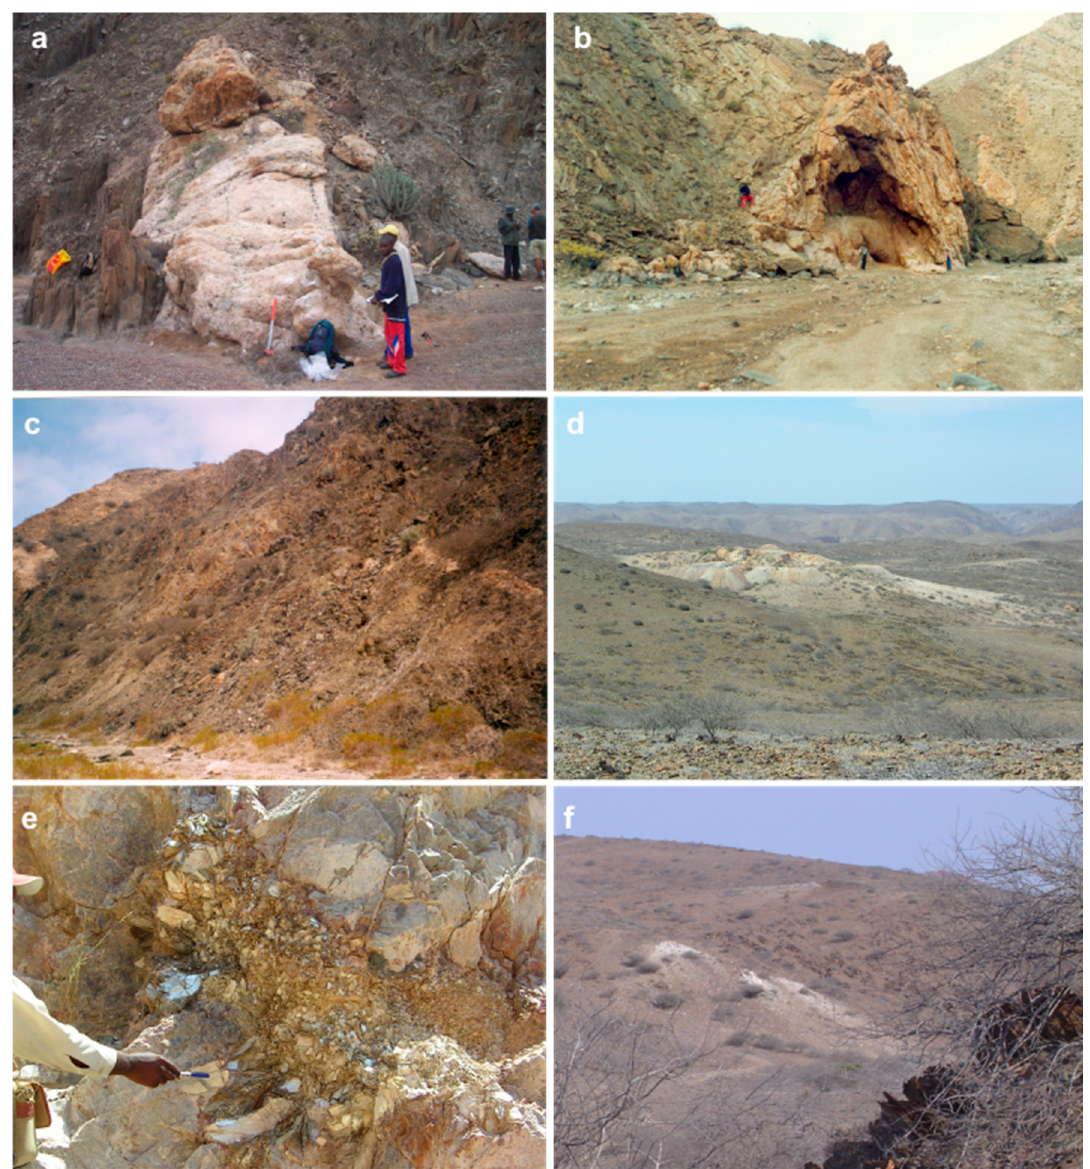
Figure 3. Outcrops from the Giraúl pegmatites. ( a ) type-II pegmatites, ( b ) large type II pegmatite, ( c ) subhorizontal dykes of type-III pegmatites, ( d ) general view of a type III pegmatite, ( e ) Quartz-muscovite vein of the type-III pegmatite, ( f ) general view of a type-V pegmatite.